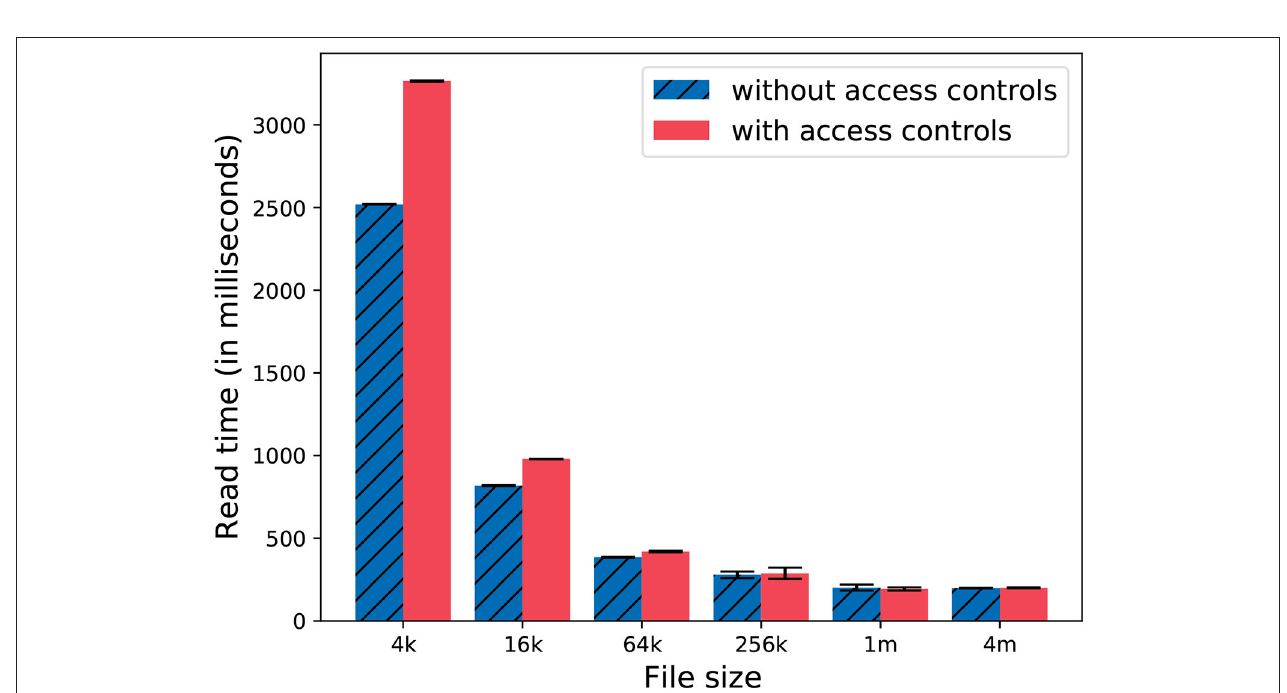
FIGURE 9 | Reading 1 GB of data with different file sizes.